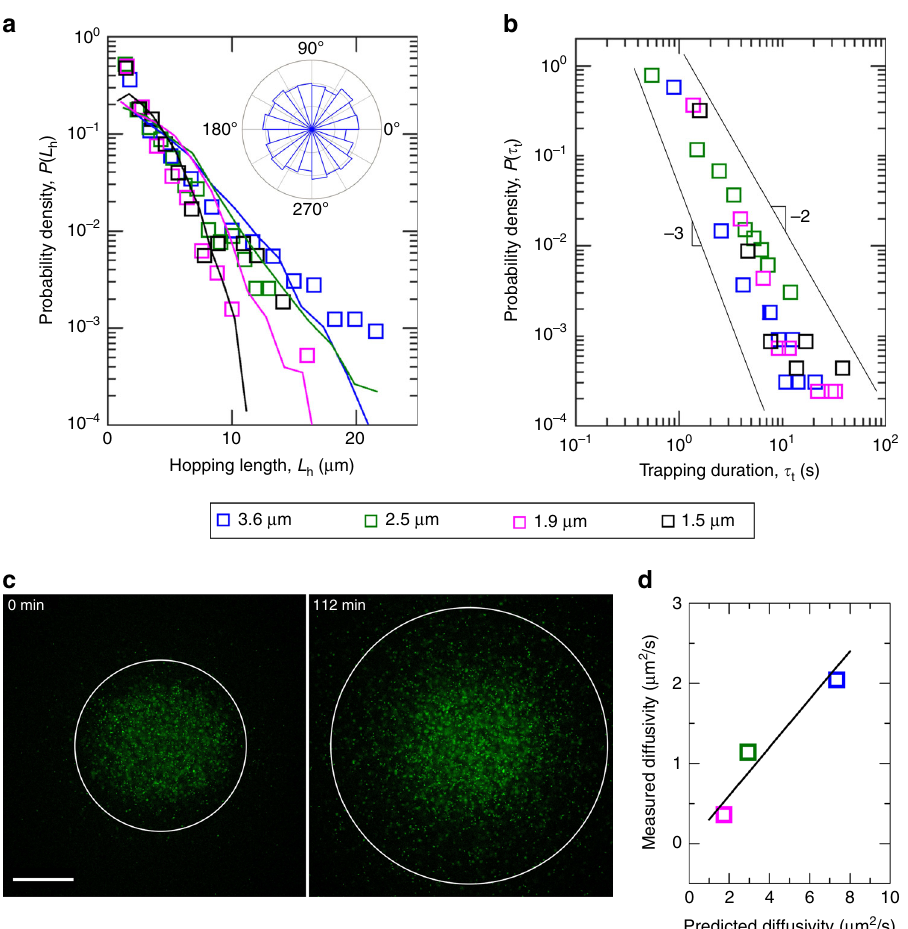
Fig. 4 Measurements of hopping and trapping predict long-time translational diffusivity of bacteria. a Probability density of the measured hopping lengths for all hops; legend indicates characteristic pore sizes of the different media. The mean hop lengths are 3.24, 2.79, 2.14, and 2.14 μ m from least dense to most dense medium. Curves show measured distribution of lengths of straight chords that can fi t within the pore space. The agreement between the two indicates that hops are guided by the geometry of the pore space. Inset shows the distribution of hop orientations, indicating that hopping is completely random in space. b Probability density of the measured trapping durations for all traps; legend indicates characteristic pore sizes of the different media. We observe power-law scaling over three decades in probability characteristic of trapping in other disordered systems. c Confocal micrographs, taken 112 min apart, of a bolus of bacteria spreading within a 3D porous medium with characteristic pore size 3.6 μ m; circle indicates the boundary of the bolus, determined using a threshold fl uorescence intensity. Measuring the expansion of this boundary provides a way to directly quantify the long-time translational diffusivity due to cellular motility. Scale bar represents 250 μ m. d Measurements of the long-time diffusivity agree with the prediction of a hopping-between-traps model. Points indicate three separate experiments in media with different pore sizes as indicated by the legend. Straight line indicates measured value = 0.3× predicted